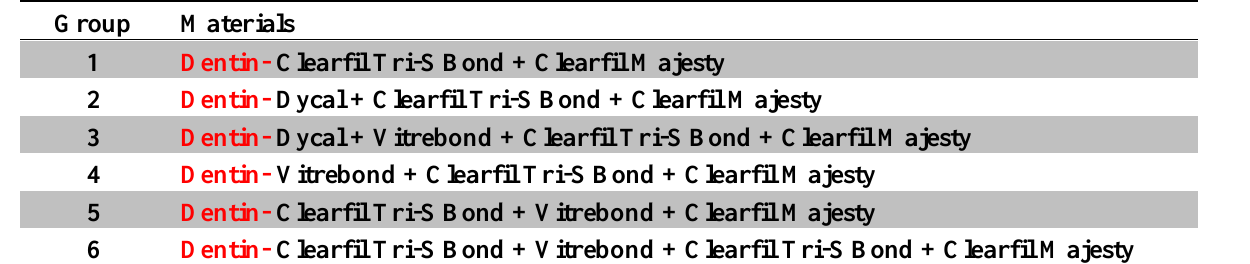
Table 2. The six experimental groups of the